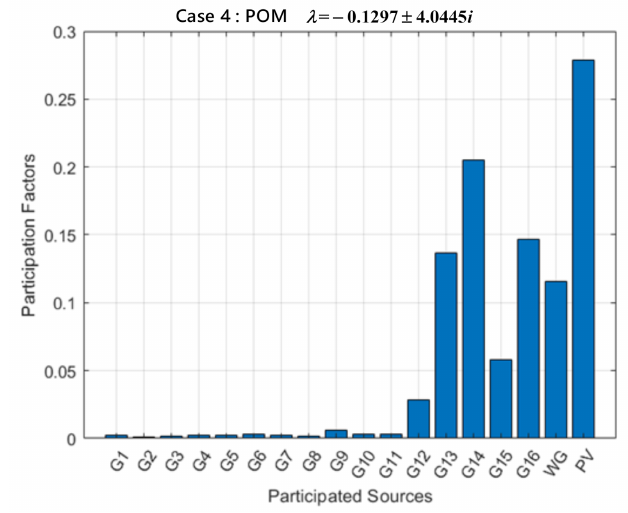
Figure 9. Participation factor analysis for closed-loop POM in Case 4.